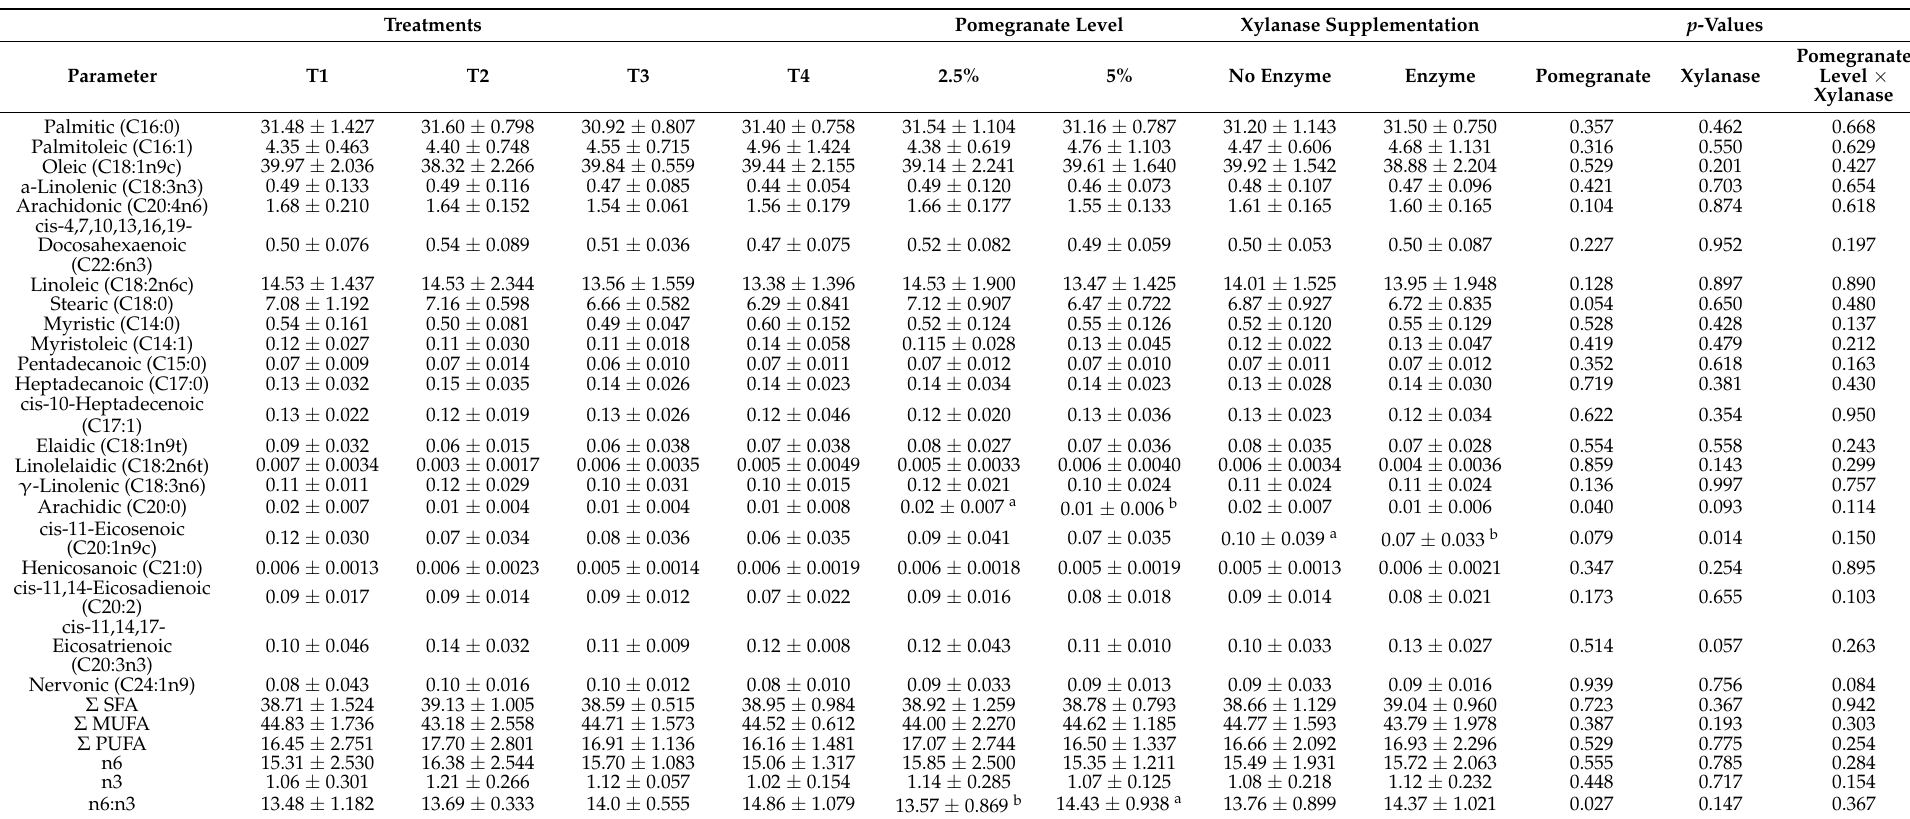
Table 5. Effects of two levels of pomegranate peel byproduct with or without xylanase on egg yolk fatty acid profile. T1: 2.5% PPB; T2: 2.5% and xylanase; T3: 5% PPB; T4:5% PPB and xylanase. Values are means ± SD ( n = 12 per